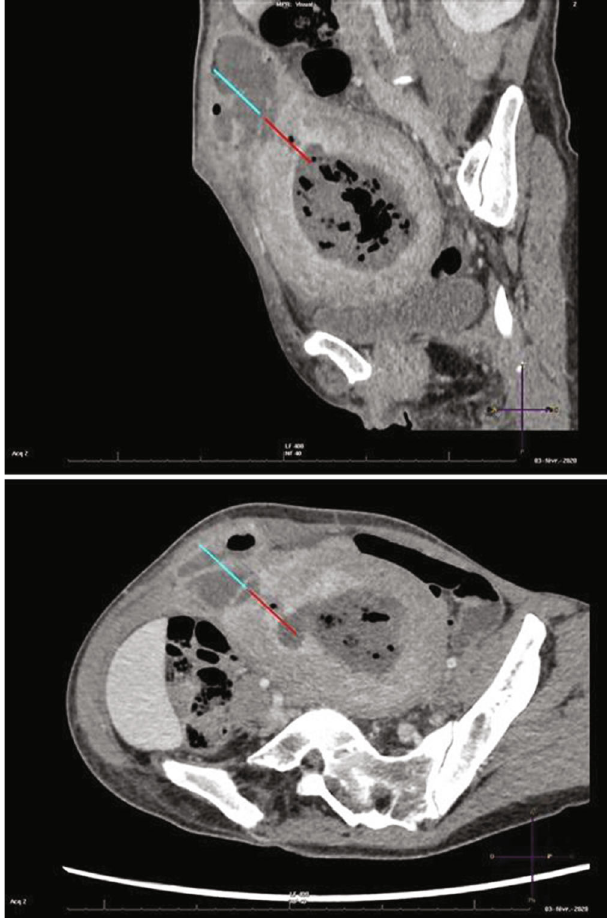
Figure 1: Carbuncle in the right iliac fossa.